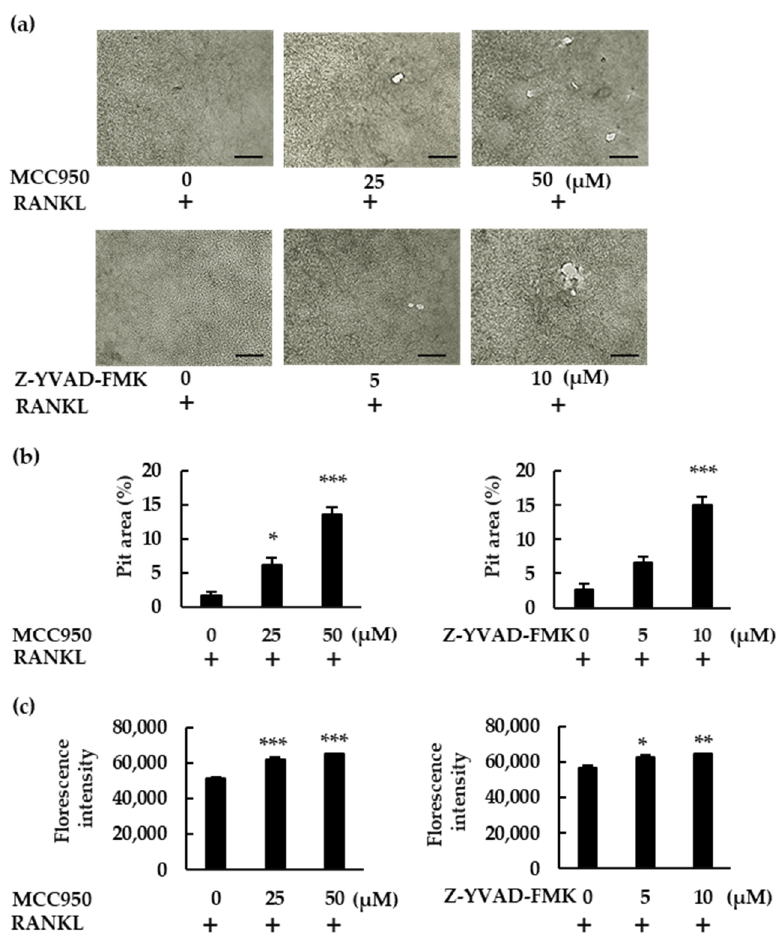
Figure 4. MCC950 and Z-YVAD-FMK upregulate bone-resorption activity in BMMs treated with RANKL. ( a ) BMMs were treated with M-CSF (30 ng/mL) and RANKL (20 ng/mL) in the presence of the indicated concentrations of MCC950 or Z-YVAD-FMK for 4 d. The medium was then replaced with fresh medium containing the same concentrations of these reagents and incubated for another 6 d. After removing the supernatant, we treated the calcium-coated plate with 5% sodium hypo- chlorite to remove the cells. The plate was then dried and images of the pit-forming areas were captured under a microscope. ( b ) Pit-forming areas were measured using ImageJ software. ( c ) Bone- resorption capacity was also assessed via the fluorescence intensity of the supernatant, using a mi- croplate reader. Scale bars: 150 μ m. Results are expressed as the means ± SE of triplicate assays and the images are representative of three independent experiments. * p < 0.05, ** p < 0.01, *** p < 0.001 compared with the control.